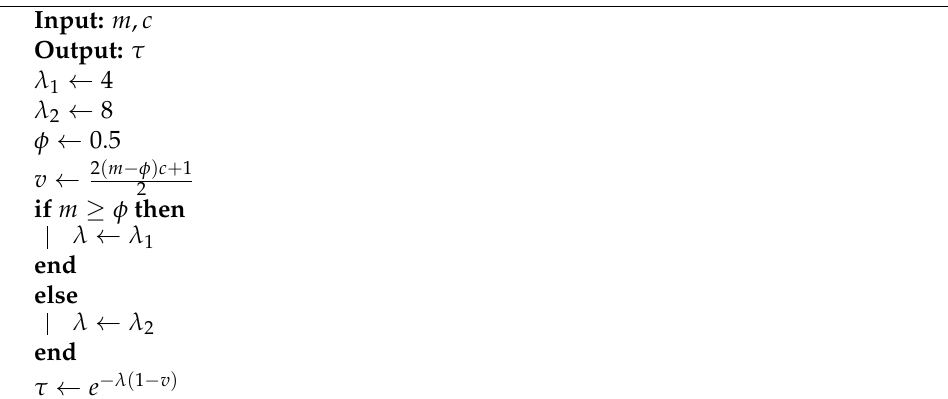
Algorithm 1: Trustability, τ , is calculated as an exponential function, where λ is decided by comparing the impression, m , with the threshold, φ